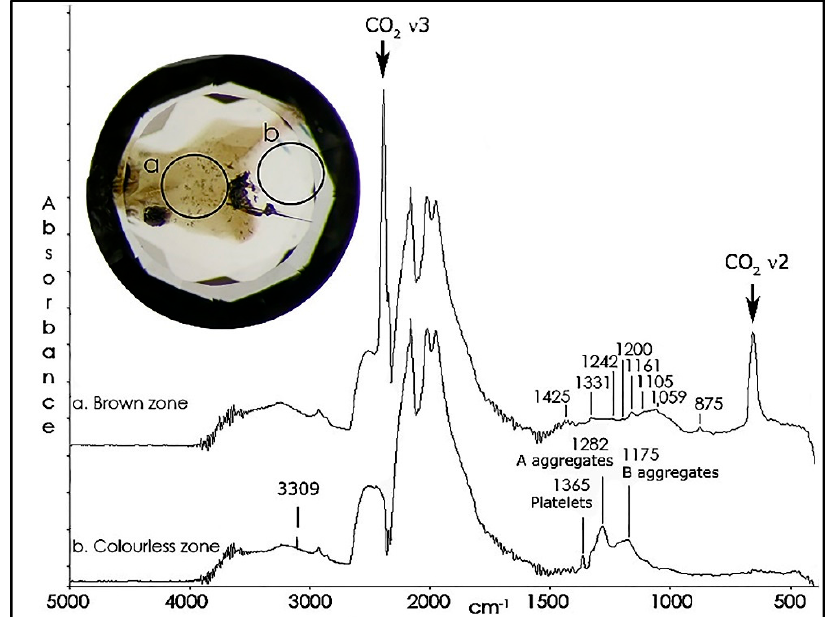
Figure 6. The IR spectra of the brown (trace a ) and the colorless (trace b ) sector of a brown CO 2 diamond (Sample TH 2.71) clearly show that the CO 2 is confined to the brown sector, while the A and B aggregate nitrogen plus the hydrogen is only detected in the colorless sector. The one-phonon absorption in the brown color zone is of unknown cause. The spectra have been shifted vertically for clarity.